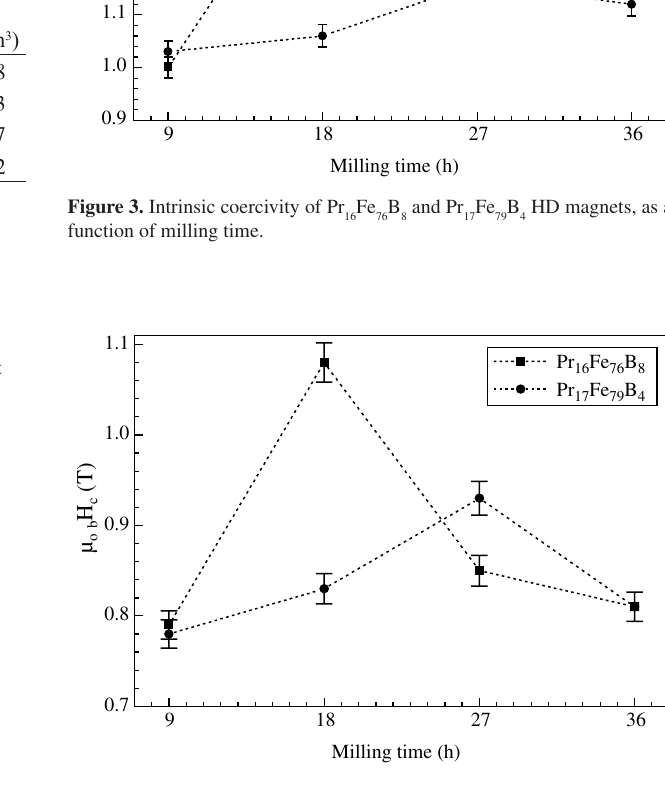
Fe B and Pr Fe B HD magnets, as 16 76 8 17 79 4